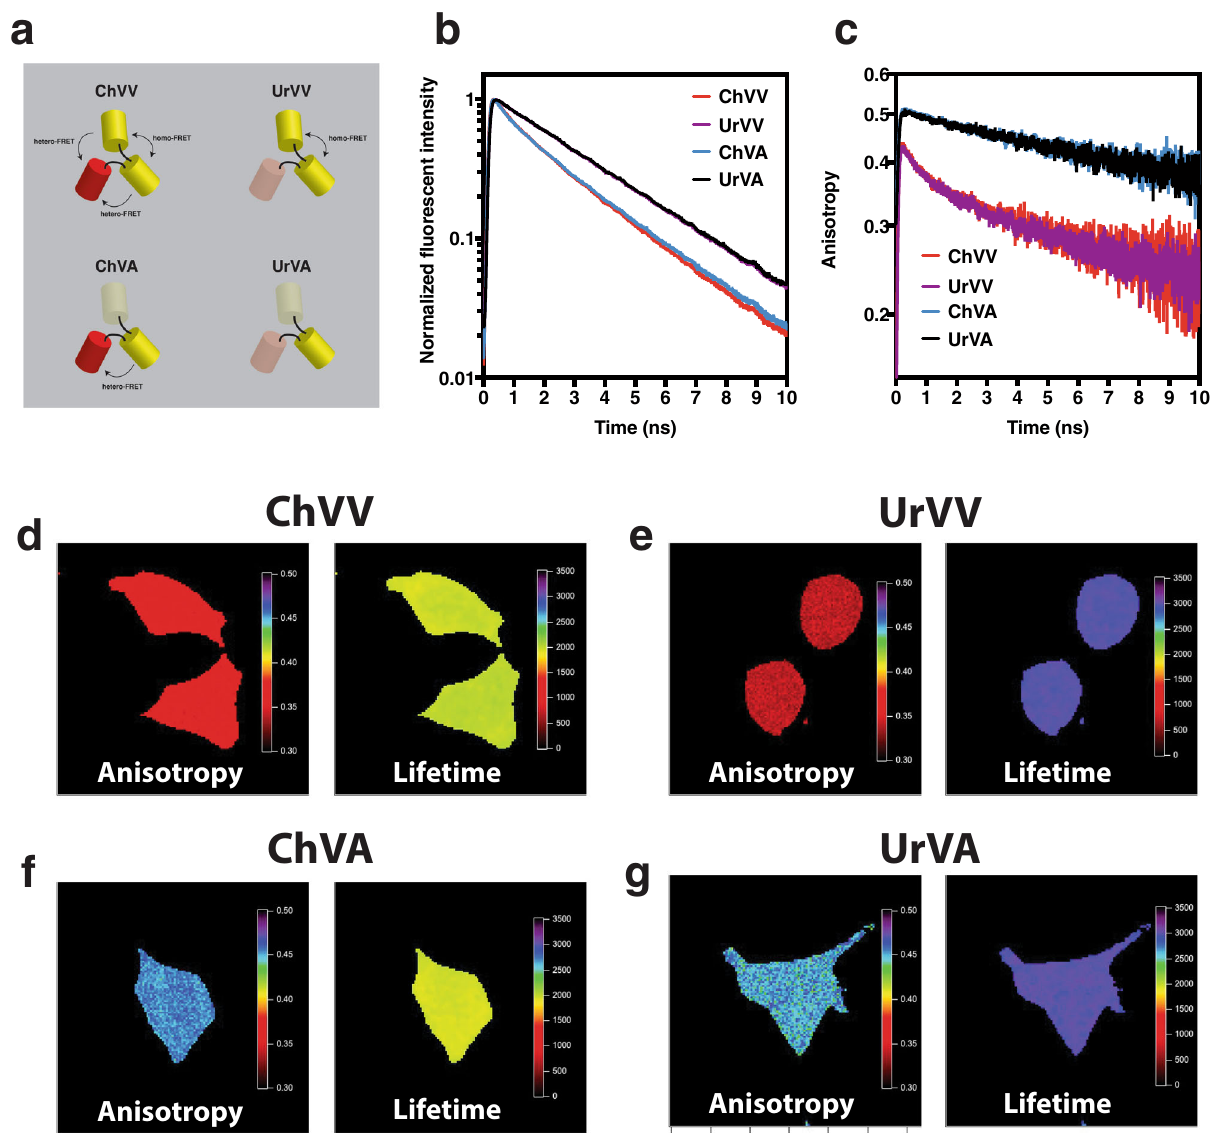
Fig. 2 | Validating binary-FRET. a Cartoon depicting fl uorescent protein control constructs. b In vitro fl uorescence lifetime decays, c In vitro time-resolved, fl uor- escence anisotropy decays. Steady-state anisotropy and fl uorescence lifetime images (128×128 pixels corresponding to 42.6 µ ×42.6 µ ) of HEK cells expressing